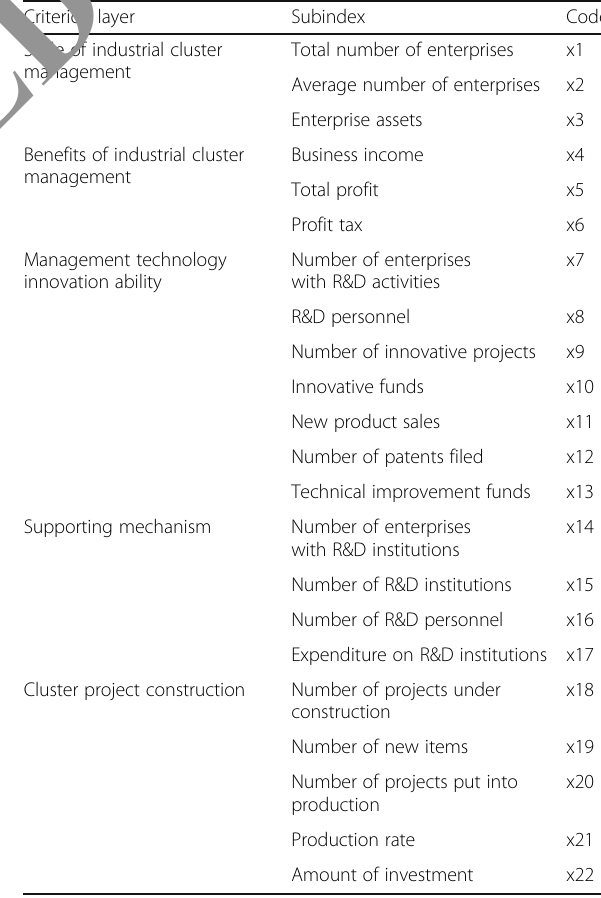
Table 1 Performance evaluation index system of industrial cluster management based on wireless network